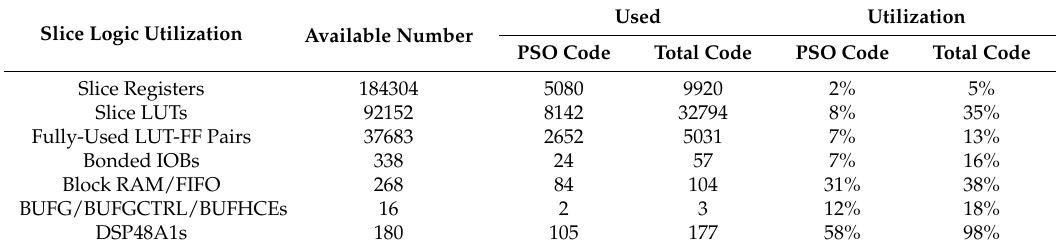
Table 8. Utilization report of FPGA Used in the Experimental System to Calculate Seven SHEM Angles in